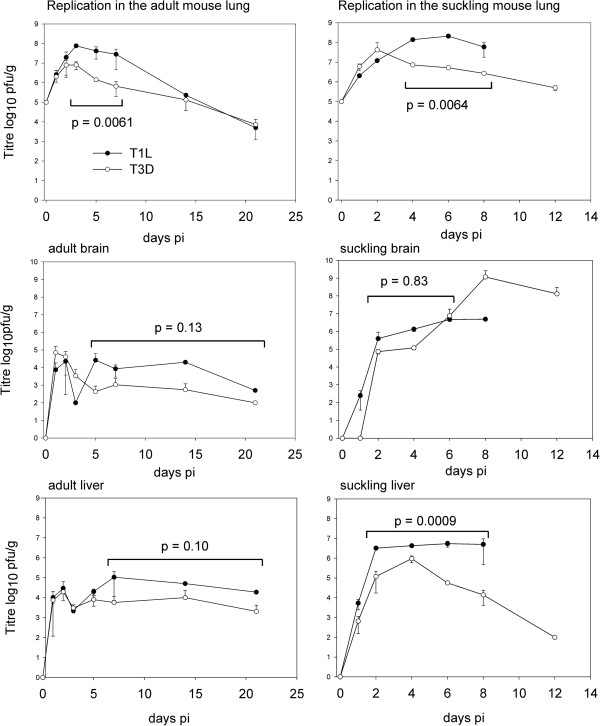
Yield of infectious virus in lung, brain and liver of adult and suckling mice. Groups of 2 adult or 2 day old suckling mice were infected intranasaly with 105 pfu of either T1L or T3D before assaying infectious virus in lung, brain and liver. The titres represent the mean of 2 animals which where titrated in duplicate for all time points except for the later 15 and 21 day time points for the T1L infections that represent single animals with duplicate titrations. The yield of infectious virus is shown + 1 SE for each time point. The yield values are closed for T1L and open for T3D. The p statistics comparing yields of virus for T1L versus T3D are indicated for groups of values in brackets (n = 6–8) that were determined by the paired students t test with significant differences considered as p ≤ 0.05 for adult and suckling lung as well as sucking liver.